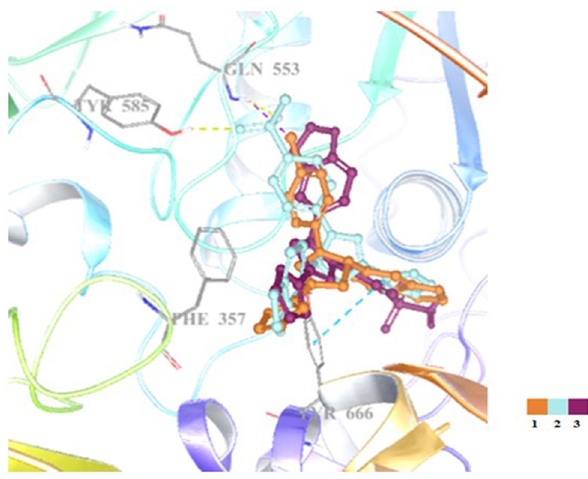
Figure 2: Docking poses of compounds 1 – 3 in the active site of DPP-4 (PDB code: